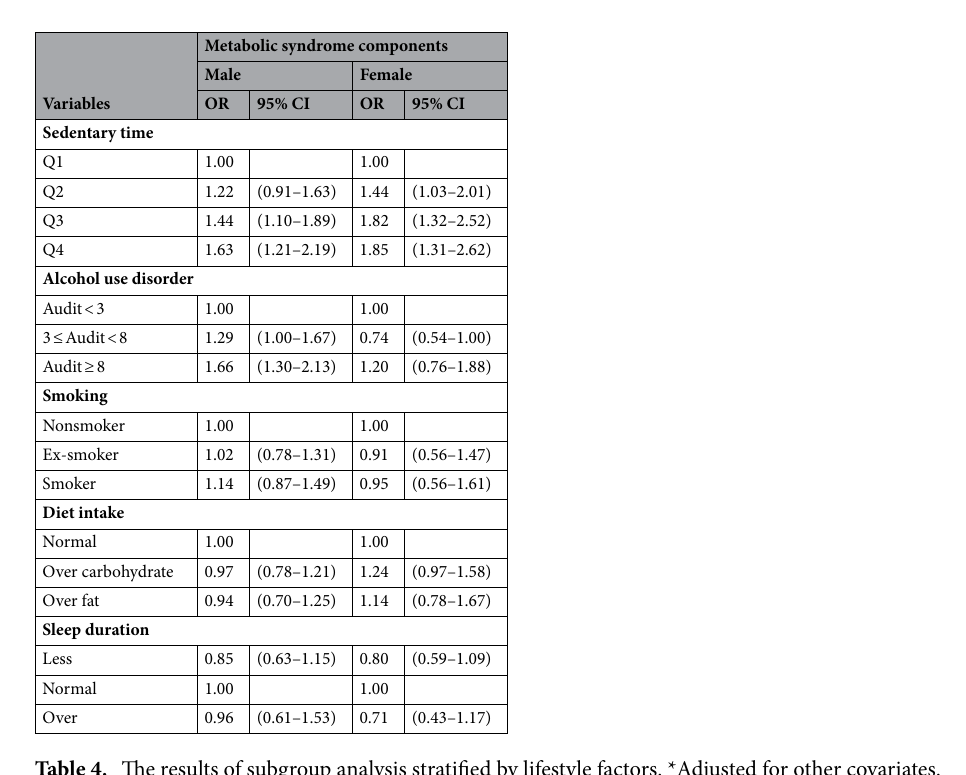
Table 4. The results of subgroup analysis stratified by lifestyle factors. *Adjusted for other